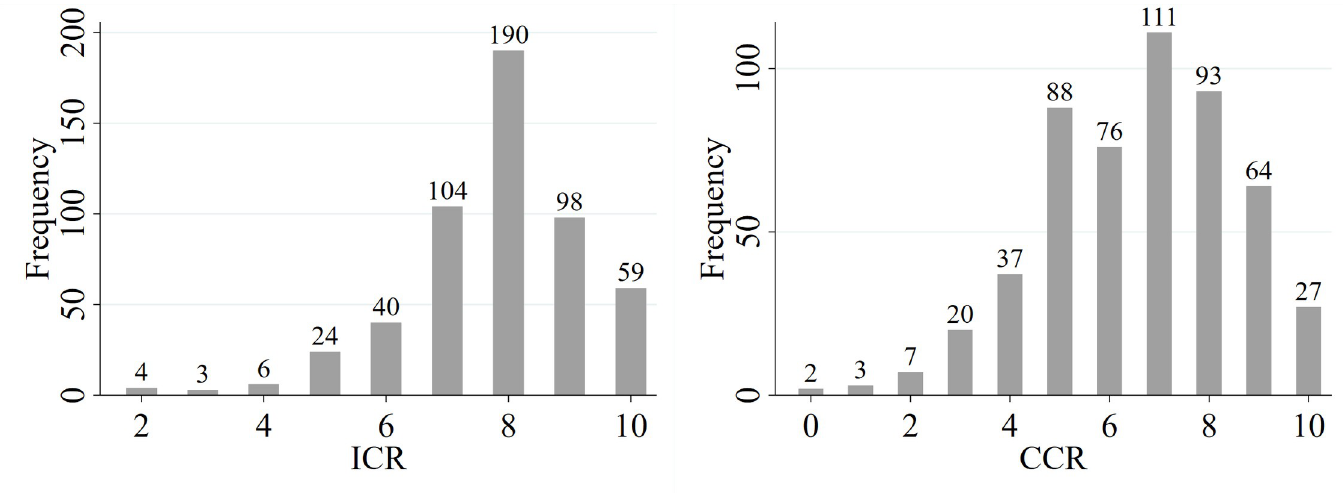
Fig 3. Individual Corporate Reputation (ICR) and perception of Collective Corporate Reputation